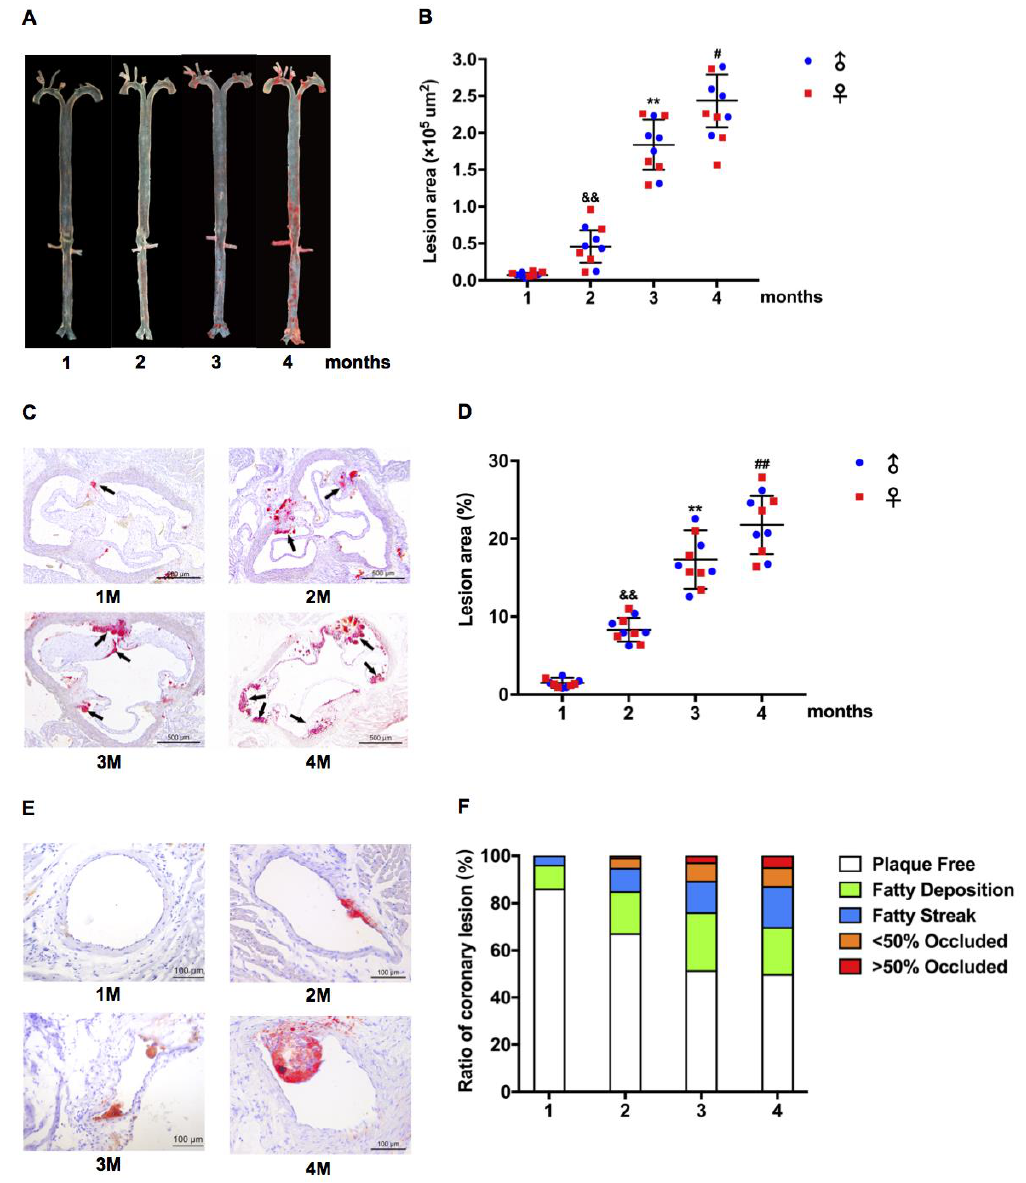
Figure 3. Time course analysis of atherosclerotic lesions in low-density lipoprotein receptor (LDLR) +/ − hamsters on HCHF diet. ( A ) Characteristics of HCHF diet-induced atherosclerosis in LDLR +/ − hamsters at indicated time points. ( B ) Lesion sizes in the whole aorta were quantified in the mixed-gender LDLR +/ − hamsters on the HCHF diets for 1, 2, 3, and 4 months. n = 10 / group. ( C ) Representative images of aortic root sections with Oil Red O staining from LDLR +/ − hamsters on the HCHF diets for 1 (1M), 2 (2M), 3 (3M), and 4 (4M) months. ( D ) Quantification of lesion areas in aortic roots. n = 10 / group. Black arrows indicate Oil Red O positive staining. ( E ) Representative images of coronary arteries stained with Oil Red O staining from LDLR +/ − hamsters on the HCHF diets for 1 (1M), 2 (2M), 3 (3M), and 4 (4M). ( F ) Semi-quantification of atherosclerotic lesions in the coronary arteries of each group. n = 30 / group. && p < 0.01 vs. group 1, ** p < 0.01 vs. group 2, # p < 0.05, ## p < 0.01 vs. group 3 in ( B ) and ( D ).